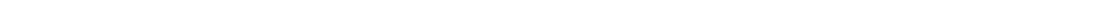
(See figure on next page.) Fig. 5 Mindin overexpression promoted production of inflammatory mediators and activation of TLR4/JNK/ NF-κB signaling after HR in vitro. A Representative photomicrographs showing the immunofluorescence of GFP in adGFP and adMindin cells. B Mindin protein expression in adGFP and adMindin cells. C – E Protein levels of TNF-α and MCP-1 in the media of cultured TECs by Western blot. *P < 0.05 versus adGFP Con or adMindn Con. # P < 0.05 versus adGFP HR. F TLR4, phosphorylated JNK, phosphorylated P65, and phosphorylated IκBα measured by western blot analysis